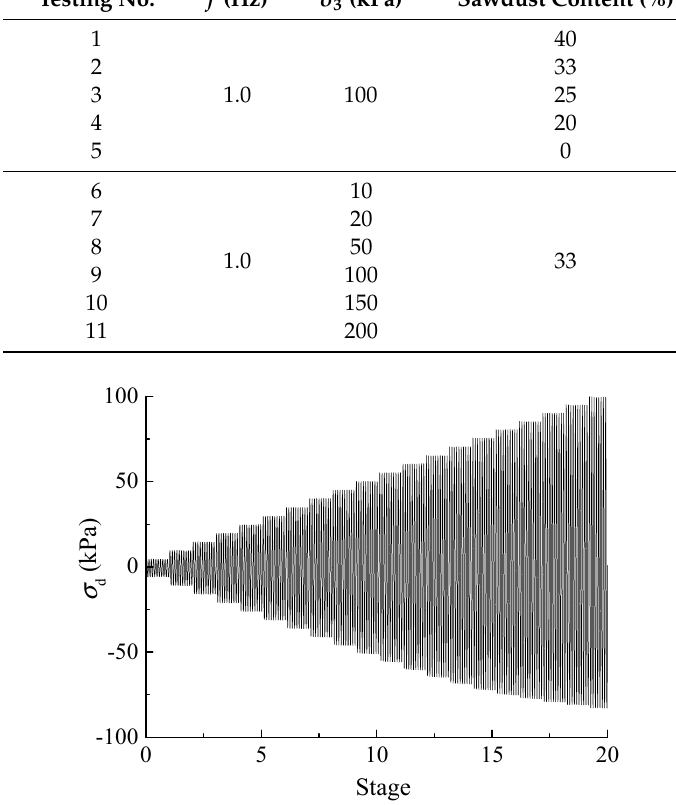
Figure 3. Typical loading curves.